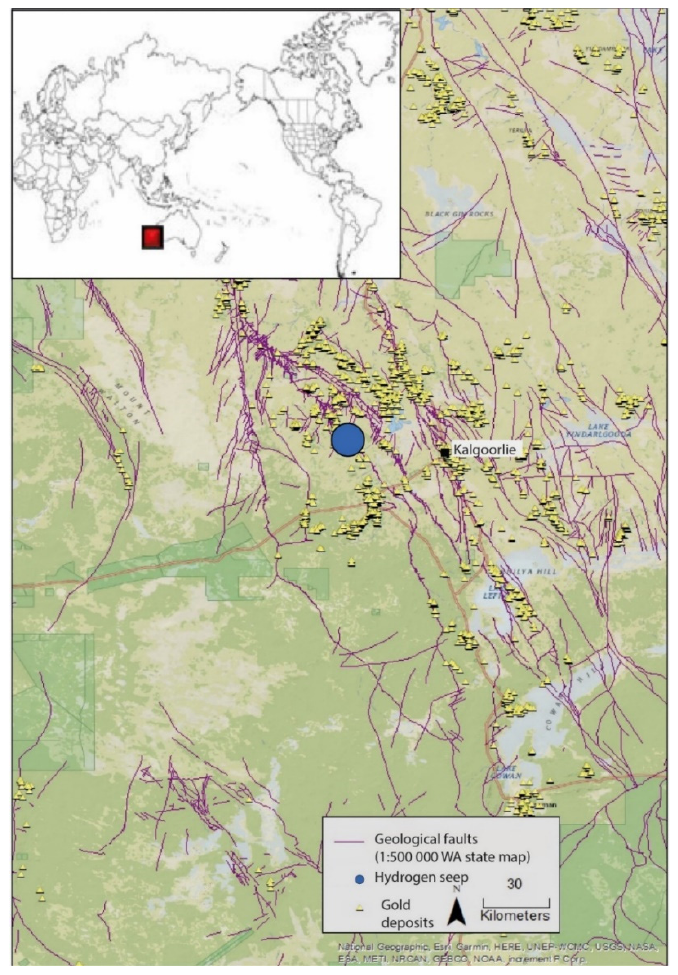
Figure 1. Field example location, northwest of Kalgoorlie, WA [22,23].